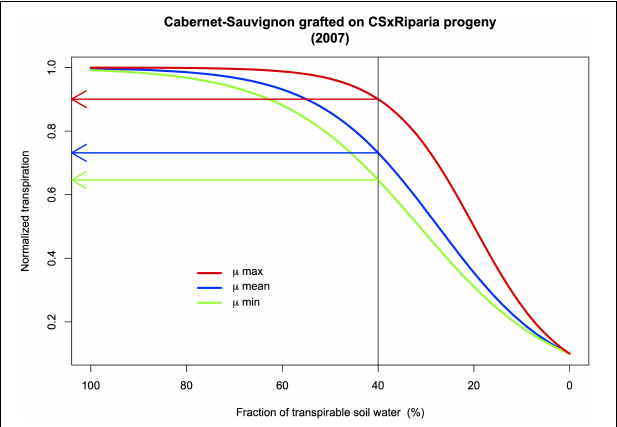
FIGURE 4 | Simulations of scion normalized transpiration rate (NTR) for Cabernet-Sauvignon according to rootstock genotypes in response to the fraction of soil transpirable water (FTSW). The relationship was: NTR = 1/(1 + 9 × e − µ × FTSW ). µ values calculated for 2009 (Marguerit et al., 2012). A QTL on chromosome 13 was identified for the µ